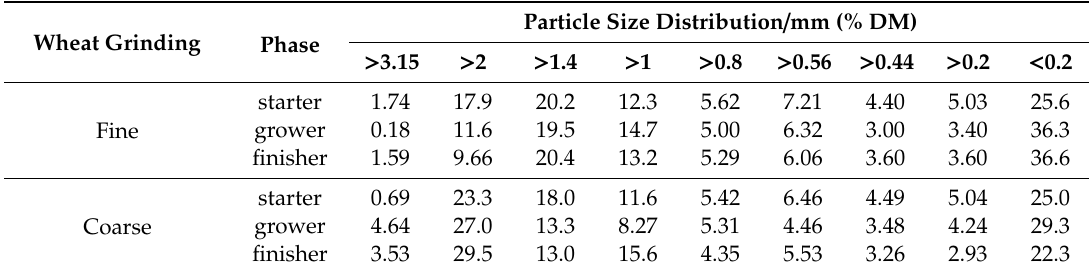
Table 2. Particle size distribution (% DM) in pelleted diets according to wet sieve analysis. Wheat